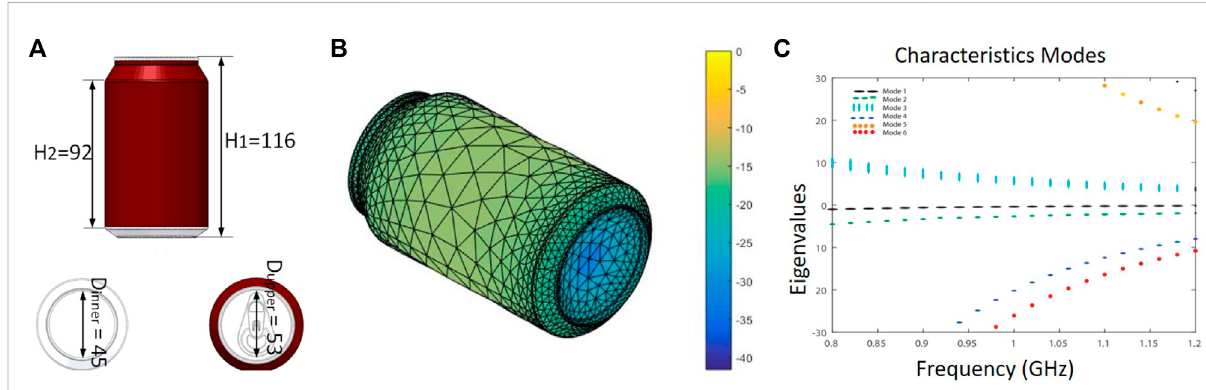
Frontiers in Communications and